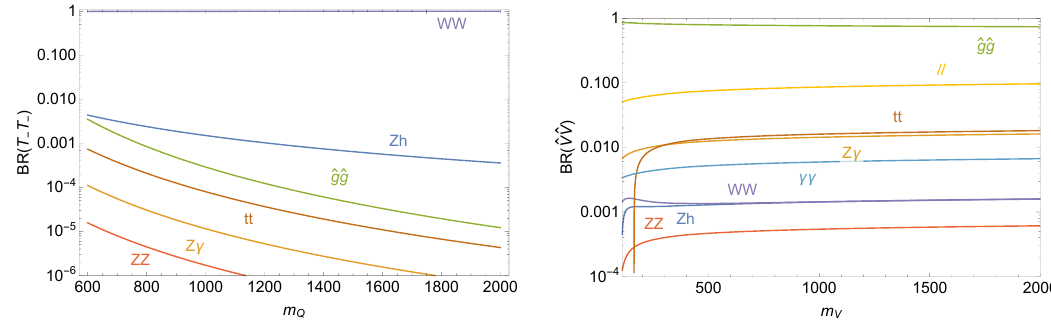
Figure 7 . Branching fraction for the s -wave quirkonium composed of the (right) quirks. The branching fraction for the